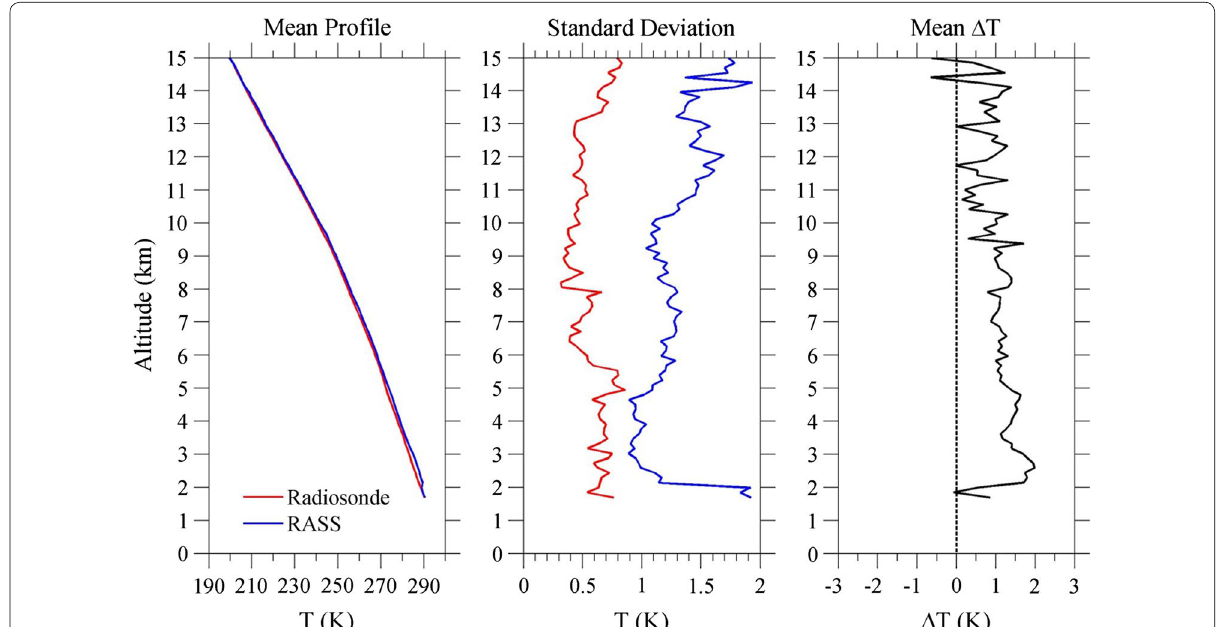
Fig. 15 Comparison of the EAR–RASS temperature profile averaged over all 10-min resolution results (blue) and the mean of 12 radiosonde results (red) from August 29 to September 3, 2016. Standard deviation of the temperature for RASS and radiosondes during the campaign is plotted in the middle panel. The mean temperature difference is shown in the right